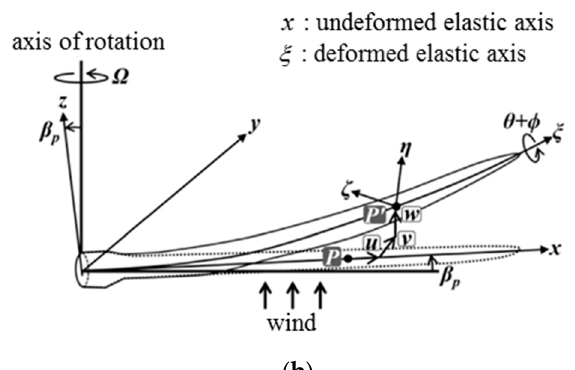
Figure 1. Coordinate systems and blade deformation kinematics. ( a ) Coordinate systems of floating offshore wind turbine. ( b ) Blade deformation kinematics (Reproduced from [9], Elsevier: 2014).